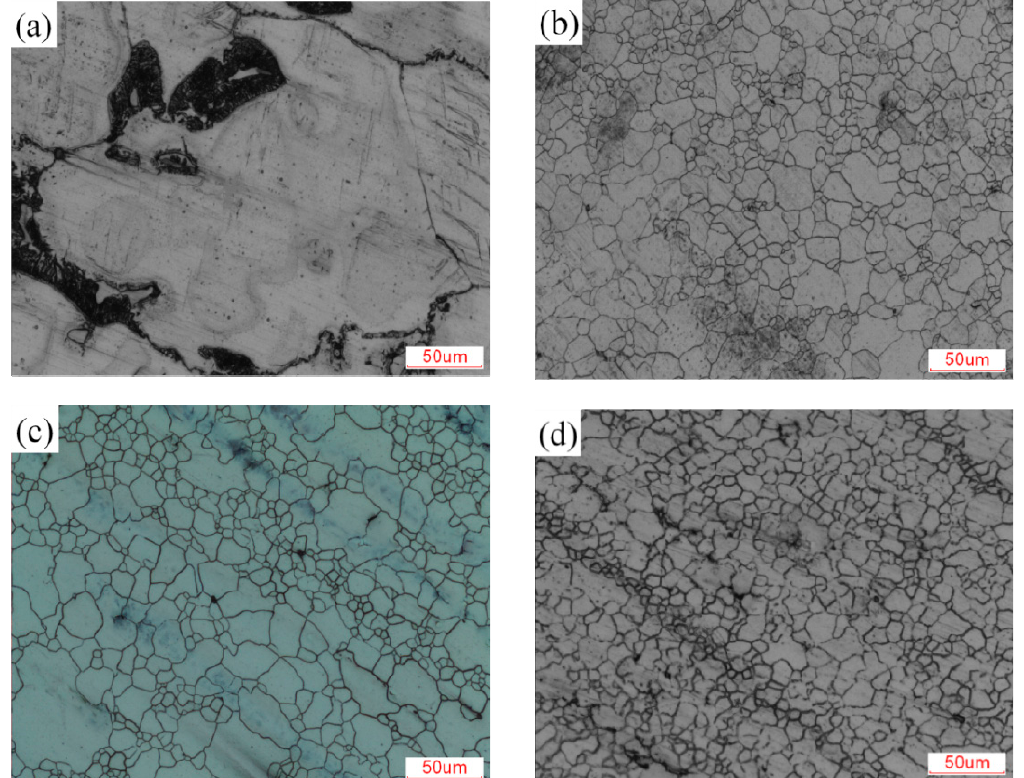
Figure 2. Optical micrographs of as-cast and ECAP processed (ECAPed) AZ61 Mg alloy ( a ) 1#, ( b ) 2#, ( c ) 3# and ( d ) 4#.